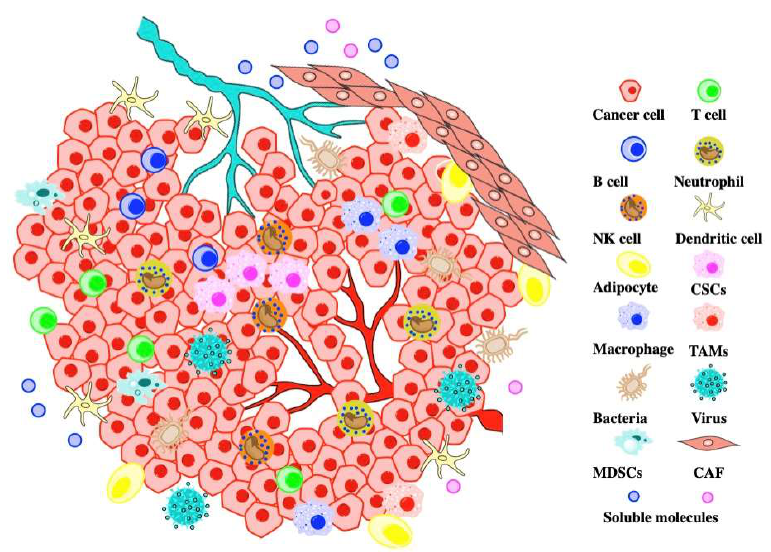
Figure 1. Various types of components in the TME of solid malignancies. The cellular composition of TME is mainly CAFs, cancer cells, immune cells, and the microbiome. All of the cells interact with each other via soluble molecules such as cytokines or chemokines and trafficking through blood vessels or lymphatic vessels (the abundance of each component is not illustrated here).